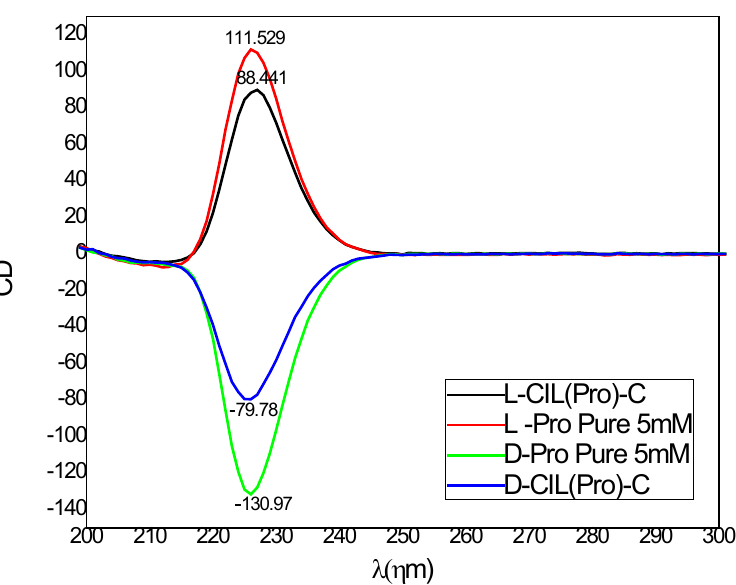
Figure 3. CD spectra of L-Pro probe (red) and D-Pro probe (green) of L- CIL(Pro)-C//Ni foil (black), and D- CIL(Pro)-C//Ni foil (blue).